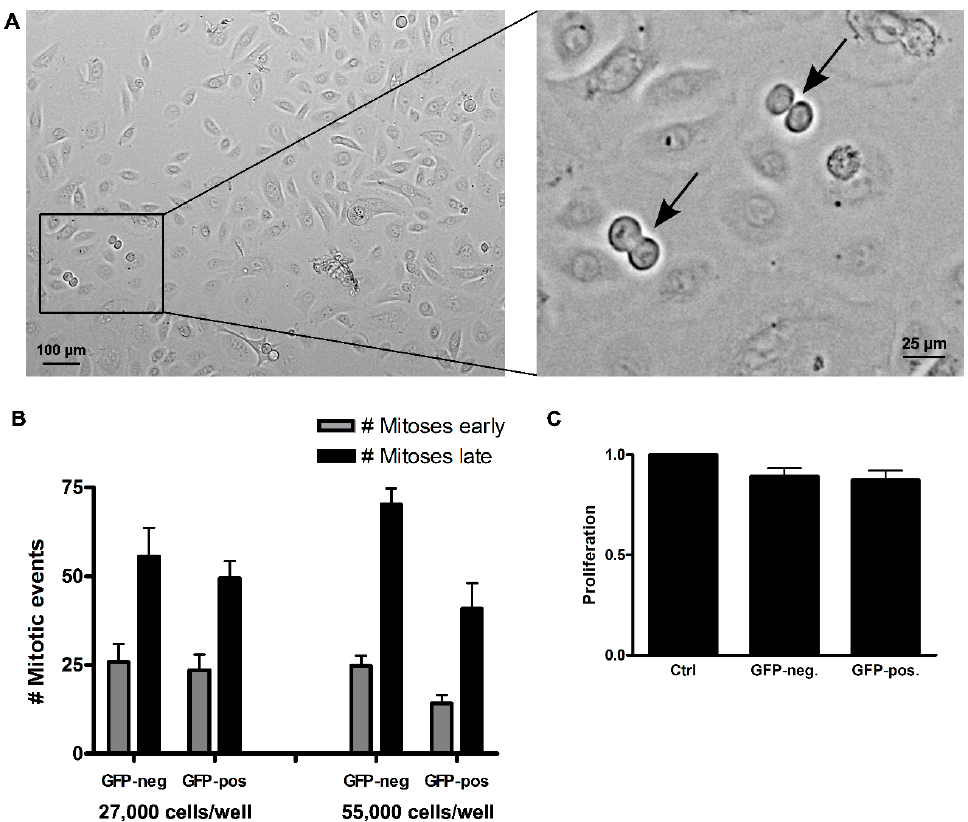
Figure 6. Effect of Numb knockdown on keratinocyte proliferation evaluated by live imaging. Equal cell numbers of FAC-sorted GFP-negative and GFP-positive cells were seeded and monitored for three consecutive days. ( A ) Representative example of one time point, showing two mitotic events (arrows); ( B ) Total mitotic events were counted over the first half (“early”, grey bars) and the second half of the time course (“late”, black bars). Comparison of mitotic numbers demonstrated a doubling for both populations at a seeding density of 27,000 cells, with roughly the same number of mitotic events at a seeding density of 55,000 cell/well; ( C ) Cell numbers were assessed by Crystal violet assay after two weeks of culture. Error bars: SEM of four replicates.